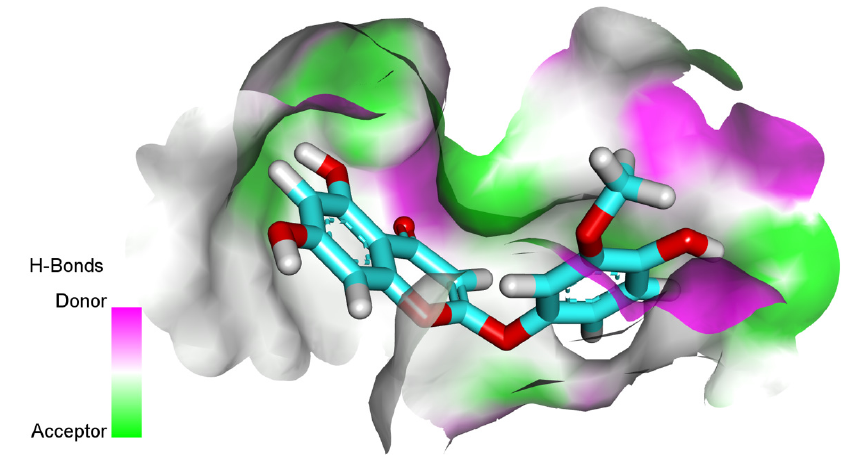
Figure 9. ( A ) 3D, ( B ) 2D, and ( C ) surface mapping of tenuflorin C ( 2 ) inside the active site of PLP.